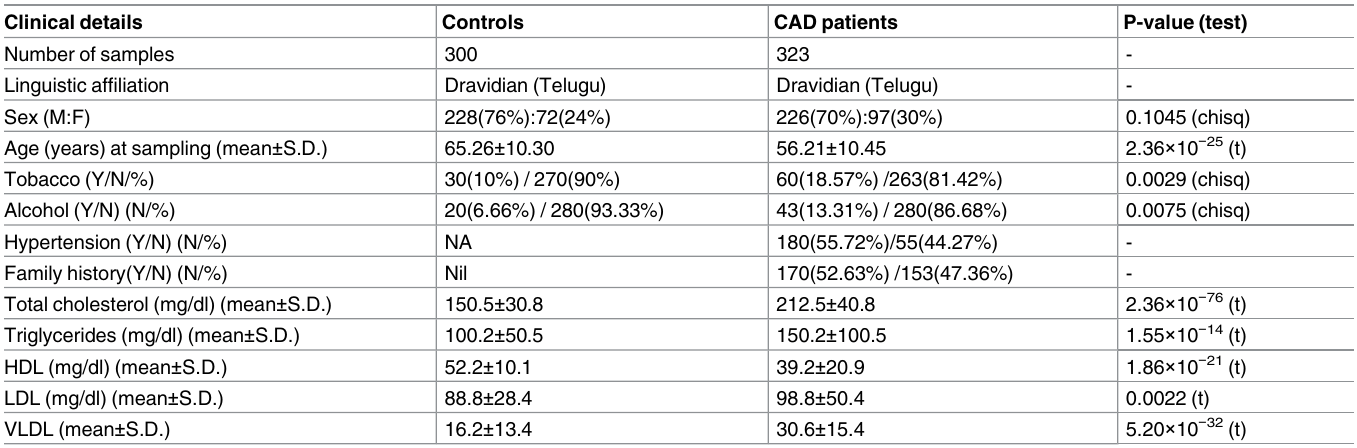
Table 1. Clinical detail of individuals included in the